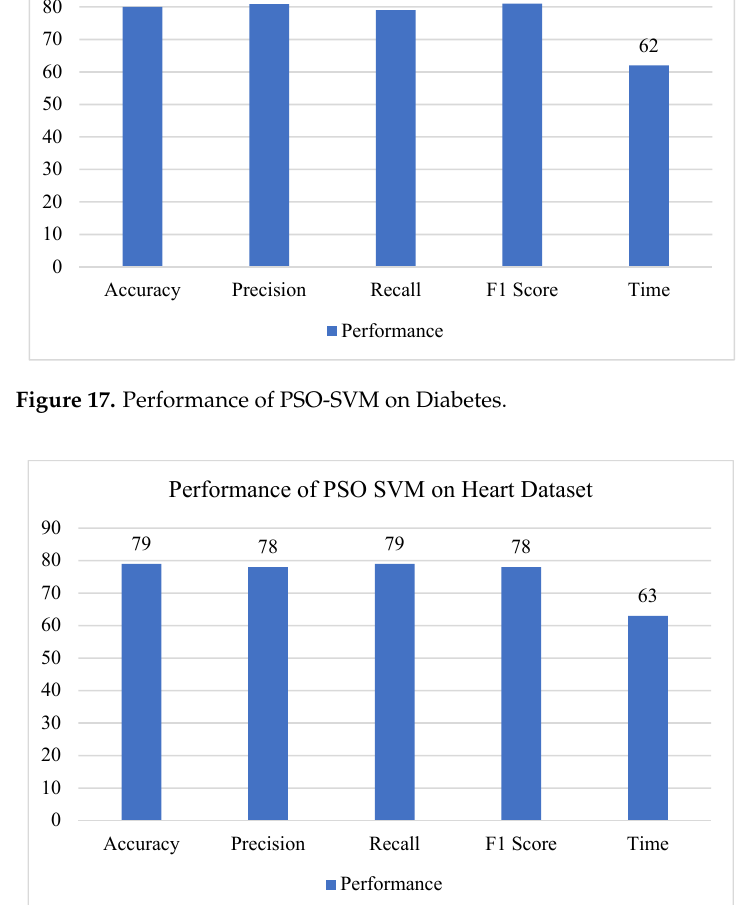
Figure 18. Performance of PSO ‐ SVM on Heart Disease . The selected best PSO ‐ SVM parameters are shown in Table 6. Table 6. Selected best PSO ‐ SVM parameters.